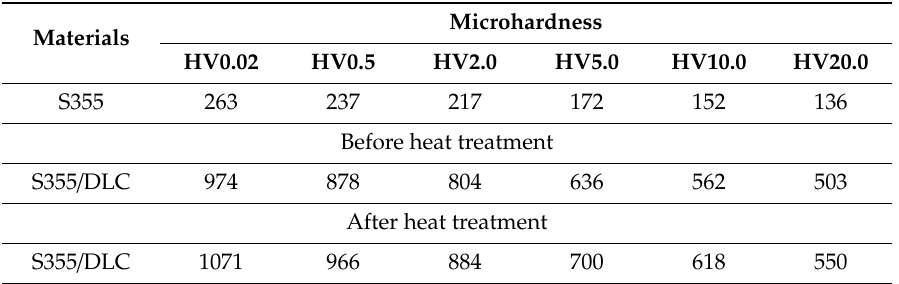
Table 2. Microhardness for the S355 steel, with and without the diamond-like carbon coating, before and after heat treatment, in air atmosphere at 400 ◦ C, in 24 h.